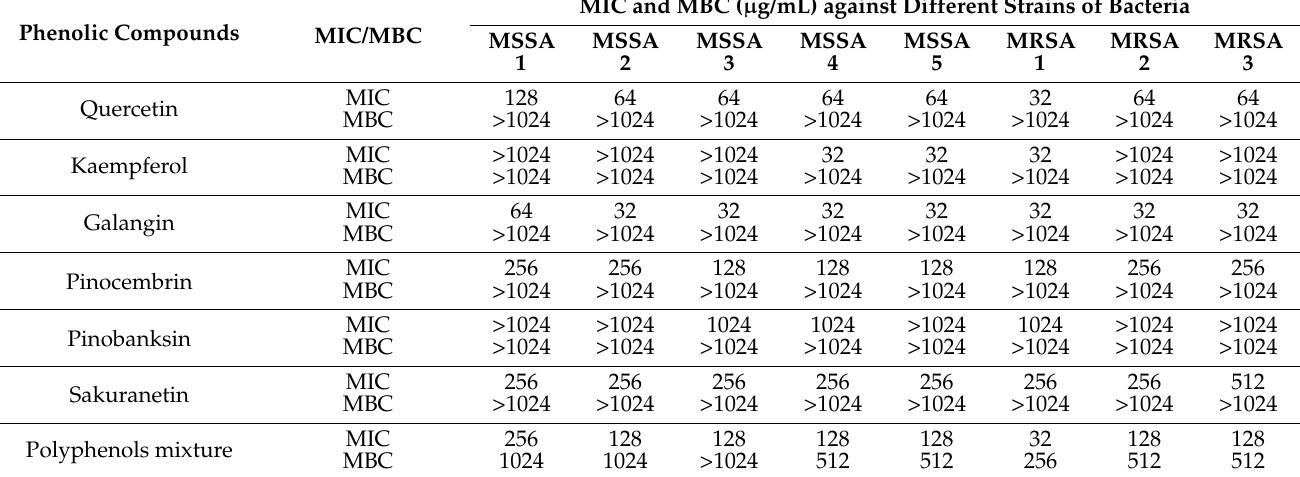
Table 6. Antimicrobial activity of propolis polyphenols and polyphenols mixture against clinical isolates of S. aureus (MSSA and